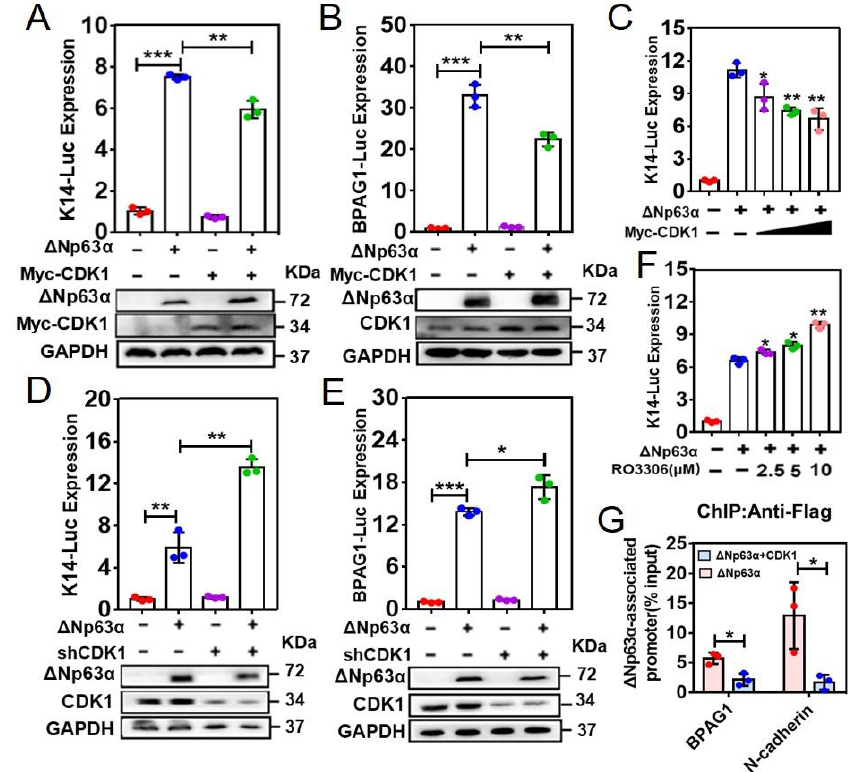
Figure 2. CDK1 impairs association of ∆ Np63 α with its downstream gene promoters to inhibit ∆ Np63 α -mediated transcriptional regulation. ( A – F ), HEK293 cells were transfected with a mixture of K14- or BPAG1-Luc and TK-Renilla, plus Flag- ∆ Np63 α and Myc-CDK1, shCDK1#1, increasing dose of Myc-CDK1 or RO3306 (a specific CDK1 inhibitor), as indicated. Firefly and Renilla luciferase activities were measured, while IB analyses were performed to detect indicated proteins in parallel. The K14- or BPAG1-Luc expression levels were normalized to Renilla activity and presented as means ± SD (n = 3). Two-tailed t -test was used for comparison between two groups; ***, p < 0.001; **, p < 0.01; *, p < 0.05. ( G ) Chromatin immunoprecipitation (ChIP) assays were performed with UM1 cells stably overexpressing Flag- ∆ Np63 α or Flag- ∆ Np63 α plus CDK1, using anti-Flag. DNA samples precipitated with either anti-Flag or mock IgG, as well as equivalent input, were subjected to quantitative polymerase chain amplification (qPCR) to detect fragments of BPAG1 and N-cadherin promoters. ∆ Np63 α -associated promoter fragments were assessed and normalized with input and mock IgG groups (means ± SD; n = 3; *, p <